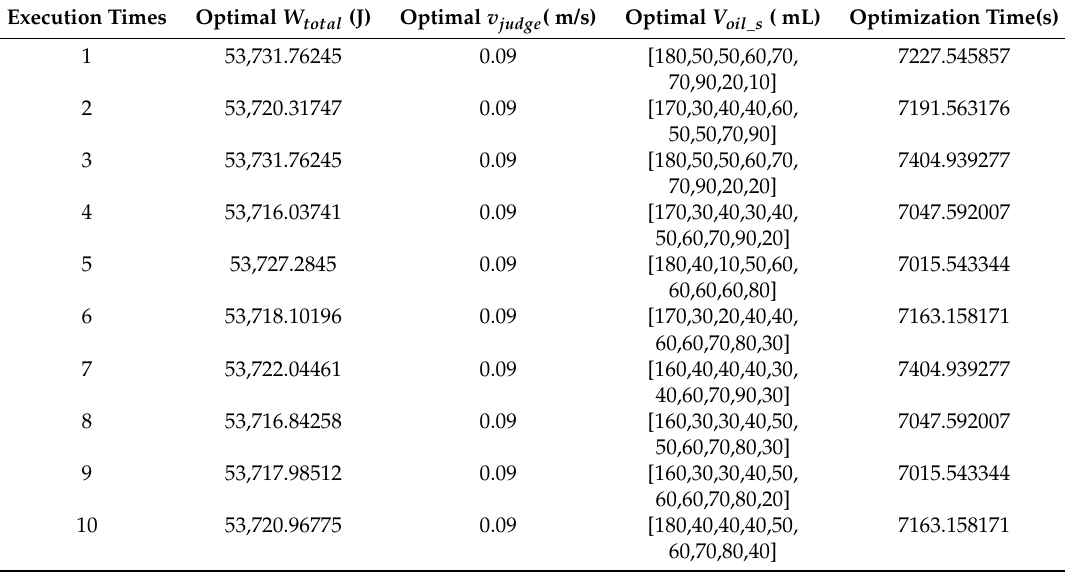
Figure 22. The optimal result of traversal method (ODR = 50 mL). Table 11. The optimization effect of the NSGA-II method after 10